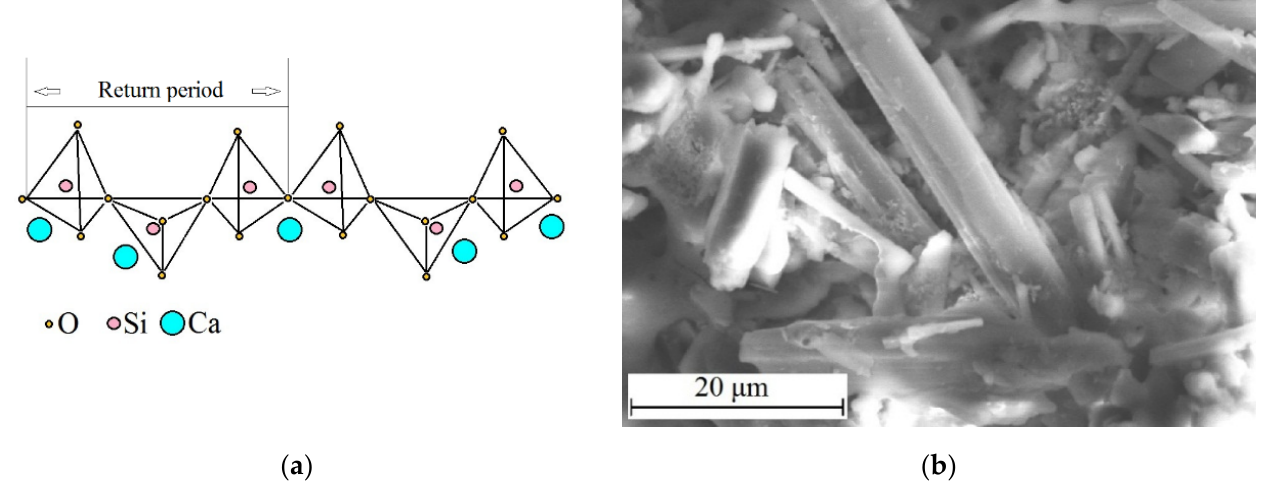
Figure 1. Scheme of the wollastonite chain ( a ), and an SEM image of the wollastonite particles ( b ).